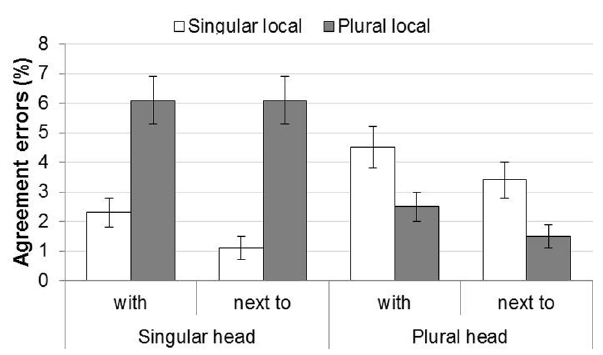
FIGURE 2 |Agreement errors in Experiment 2. Error bars show the SE of the mean across participants, for illustrative purposes.